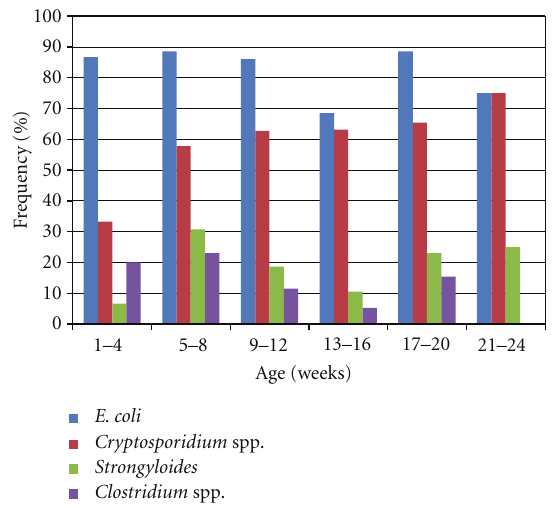
Figure 3: Frequency of detection of enteric pathogens in foals by